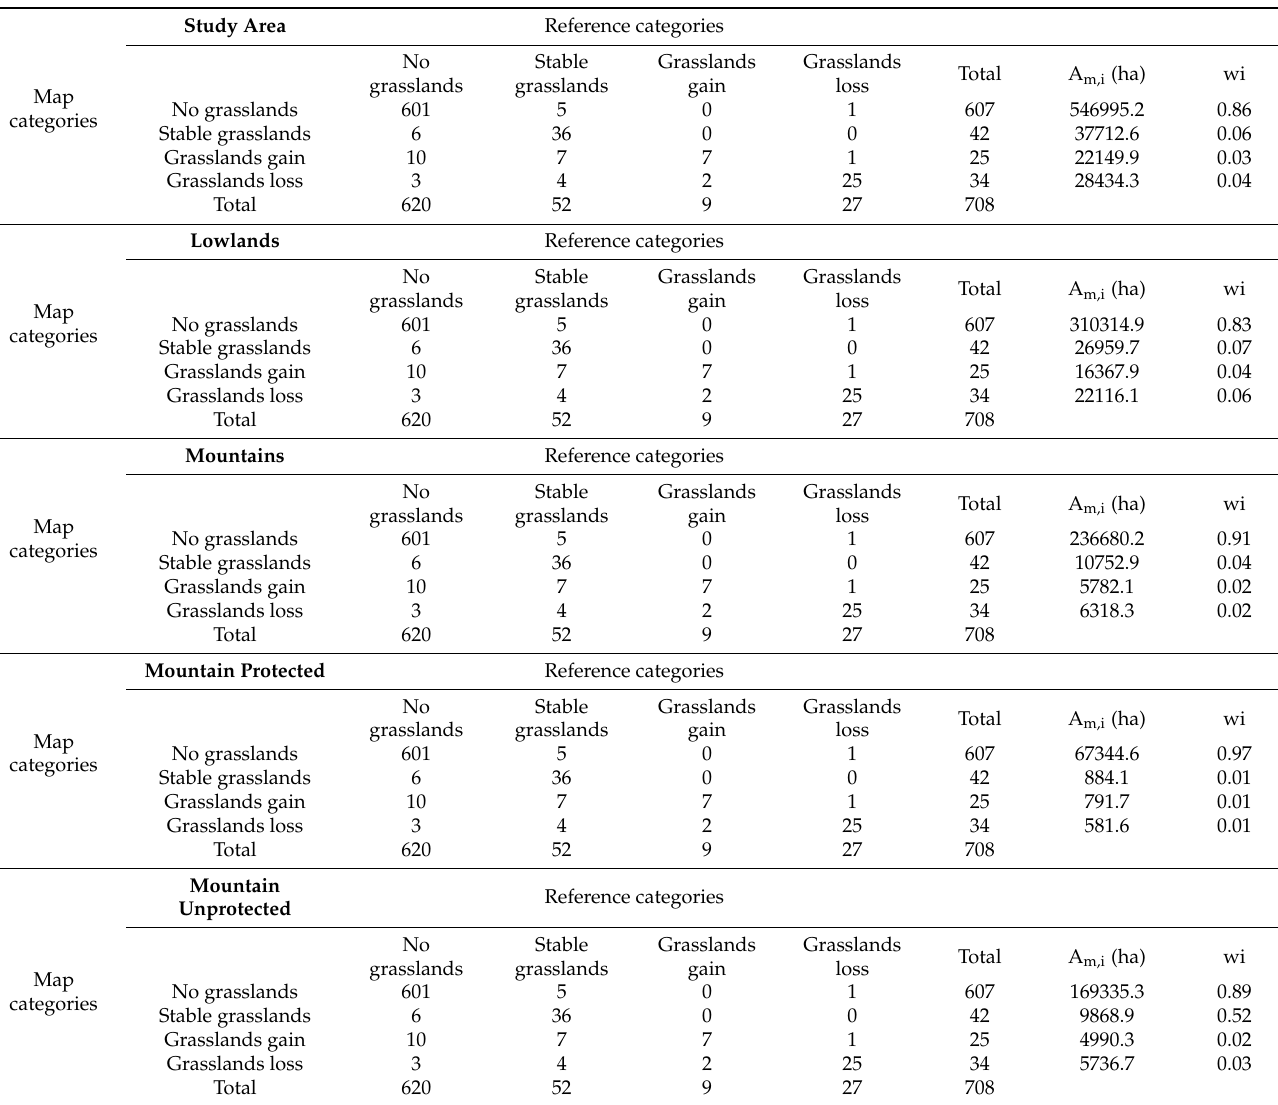
Table A2. Error matrix as sample counts (n ij ) of the grasslands change map for each extent of analysis (study area, lowlands, mountains, mountain protected and mountain unprotected). A m,i is the mapped area (ha) of category i and wi is the proportion of the mapped areas as category